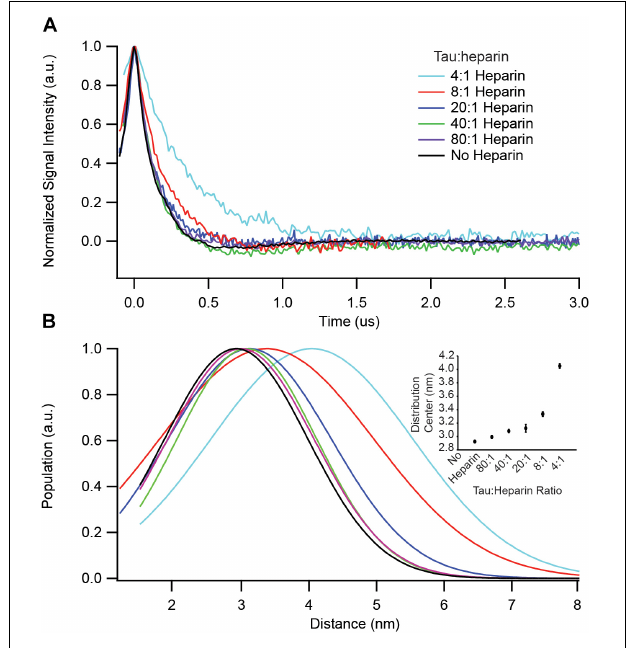
FIGURE 3 | DEER spectroscopy of doubly labeled tau187 at positions 272 and 285. Data points shown are for before (black) and 1 h after addition of the following stoichiometries: 4:1 (cyan), 8:1 (red), 20:1 (blue), 40:1 (green), and 80:1 (purple) tau:heparin molar ratio. (A) Background subtracted